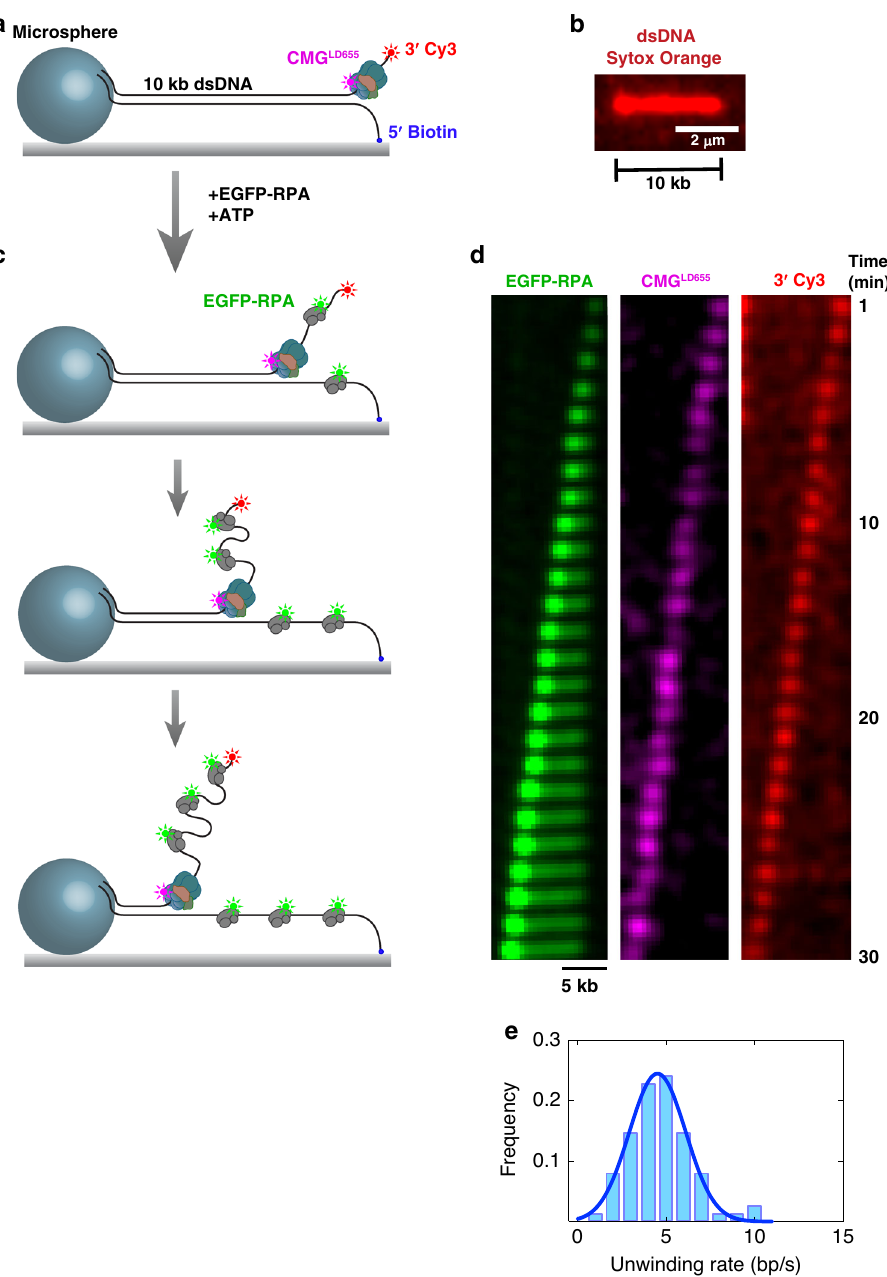
Fig. 1 Direct visualization of RPA-facilitated processive fork unwinding by individual CMG molecules. a A 10-kb fragment of λ DNA was ligated to a short fork DNA substrate at one end and to a digoxigenin-modi fi ed DNA fragment on the opposite end. The 5 ′ tail of the forked end contained a biotin to attach the 10-kb substrate to biotin-functionalized glass through biotin-streptavidin binding. The digoxigenin-modi fi ed end was coupled to anti-digoxigenin- coated microsphere to stretch DNA molecules by buffer fl ow, and to subsequently attach this end to the surface (details are described in the Methods section). The DNA substrate was labeled with Cy3 at the 3 ′ dT 40 ssDNA tail near the fork junction. LD655-labeled CMG was bound to the dT 40 ssDNA in the presence of ATP γ S. b A sample stretched 10-kb linear DNA stained with a fl uorescent dsDNA intercalator Sytox Orange. Average length of stretched DNA molecules were determined by measuring the end-to-end distance of 717 individual DNA molecules ( n = 2 independent experiments). c After binding CMG on the surface-immobilized DNA, EGFP-RPA, and ATP was introduced to initiate unwinding. While CMG unwinds DNA at the fork, EGFP-RPA binds both strands of unwound DNA. d Kymograph showing a representative 10-kb DNA being unwound entirely by a single CMG complex. EGFP-RPA (left panel), LD655-labeled CMG (center panel), and 3 ′ Cy3 (right panel) are imaged during unwinding under near-TIRF conditions. Images were acquired in the absence of buffer fl ow. e Histogram of CMG-catalyzed DNA-unwinding rates on stretched DNA (74 individual DNA molecules analyzed from two independent experiments). Source data are provided as a Source Data fi